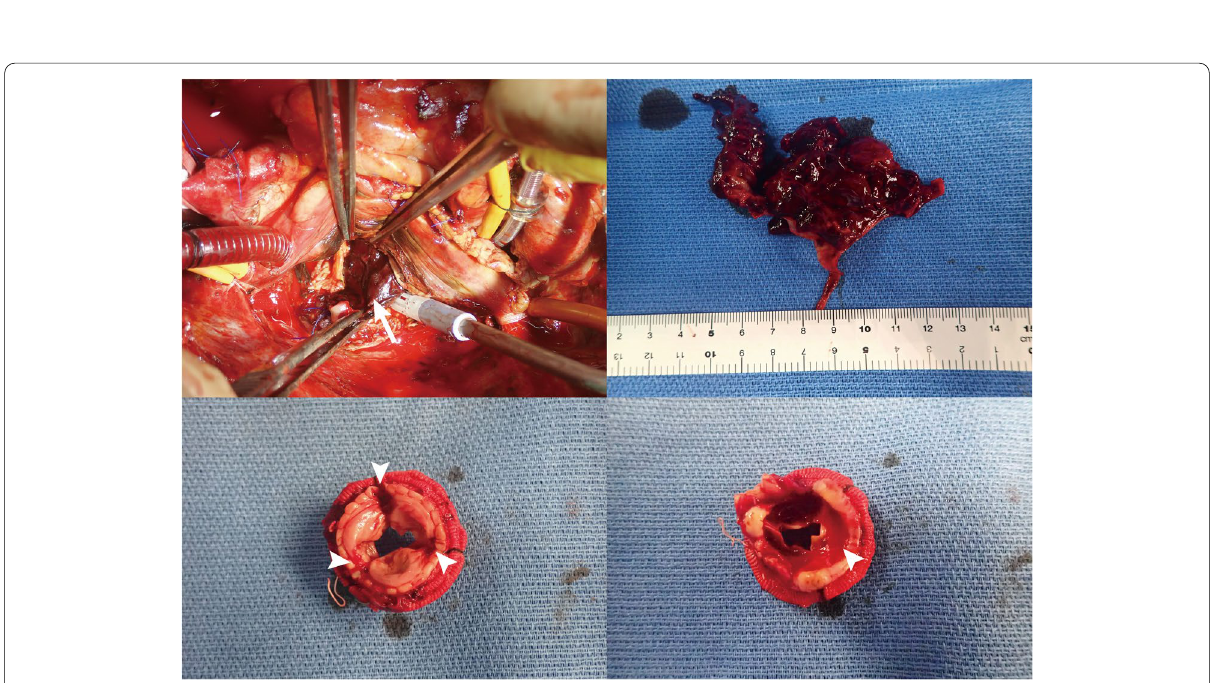
Fig. 4 The operative field during re-mitral valve replacement. There was a blood clot stuck (arrow) in the mitral valve (upper left). The upper right image shows the extracted thrombus, and the lower left and right images show the removed prosthetic mitral valve (the left atrial and ventricular sides, respectively) with blood clots (arrow